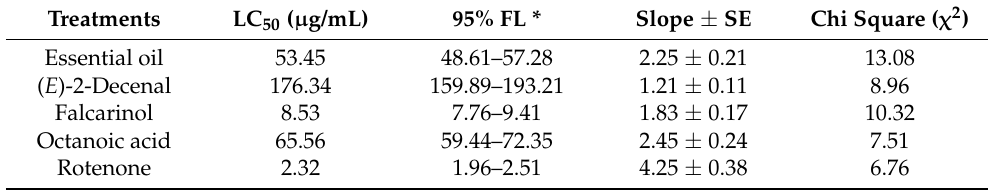
Table 2. The nematicidal toxicity of the essential oil of Seseli mairei H. Wolff roots against Bursaphe- lenchus xylophilus